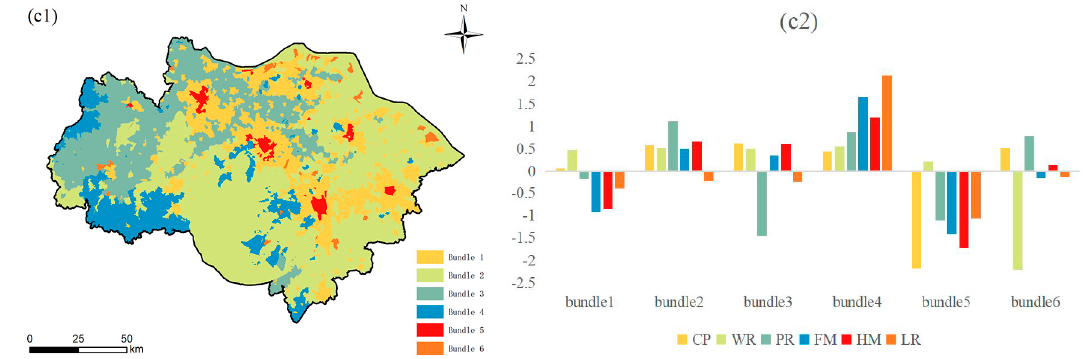
Figure 10. Spatial distribution of ES budget bundles at the village scale ( c1 ); ESDR of ES budget bundles at the village scale ( c2 ). Note: The histogram is obtained by the Z-score normalization method. The abscissa represents the six ES budget bundles at the village scale; the vertical axis is the Z-score. When Z-score = 0, it represents the average value of ESDR. Z-score > 0 indicates above-average values, and Z-score < 0 indicates below-average values.